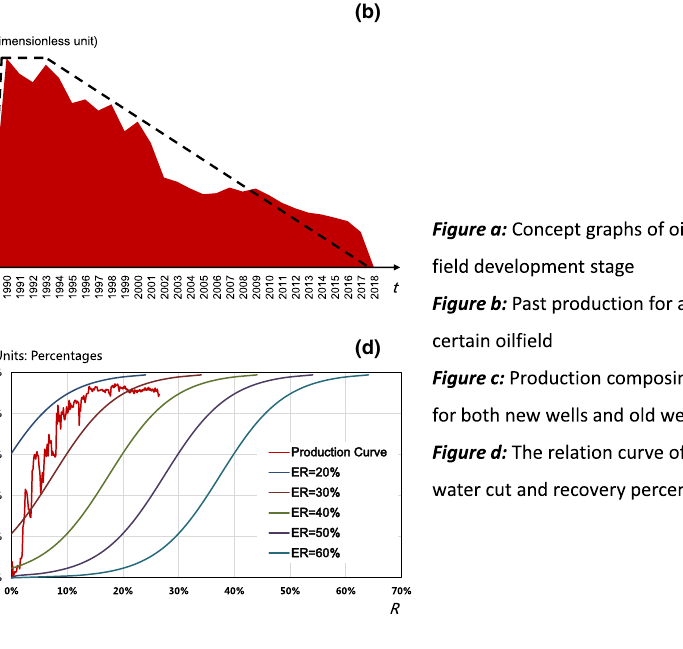
Fig. 1 Conventional development modes of